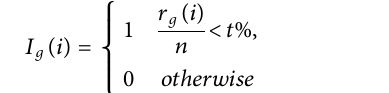
Frontiers in Genetics |